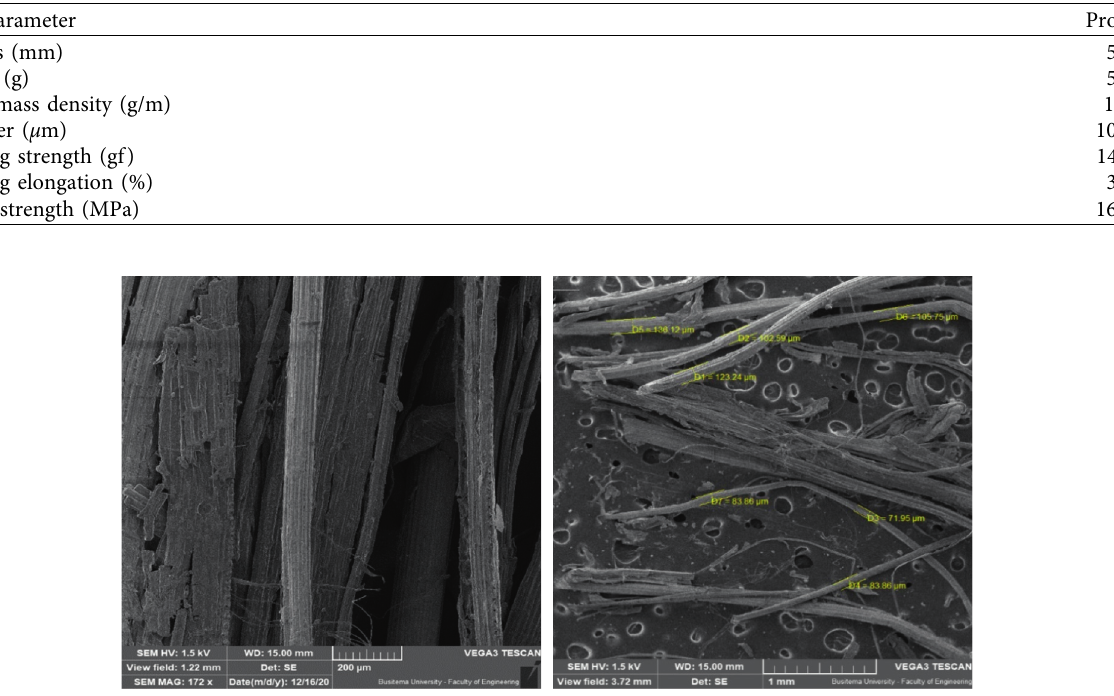
Figure 3: Images of banana fibre microstructure and